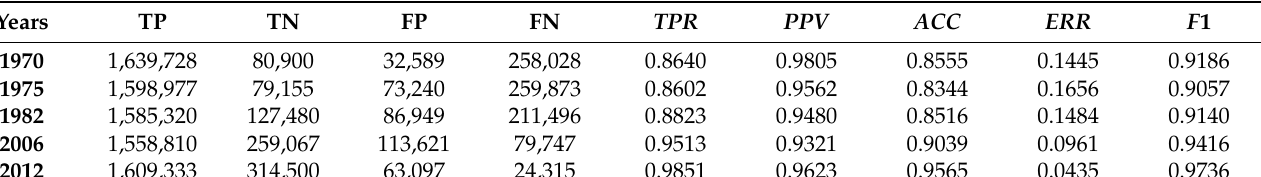
Table 5. Binary confusion matrix for all analysed years with parameters defining the quality of building detection.